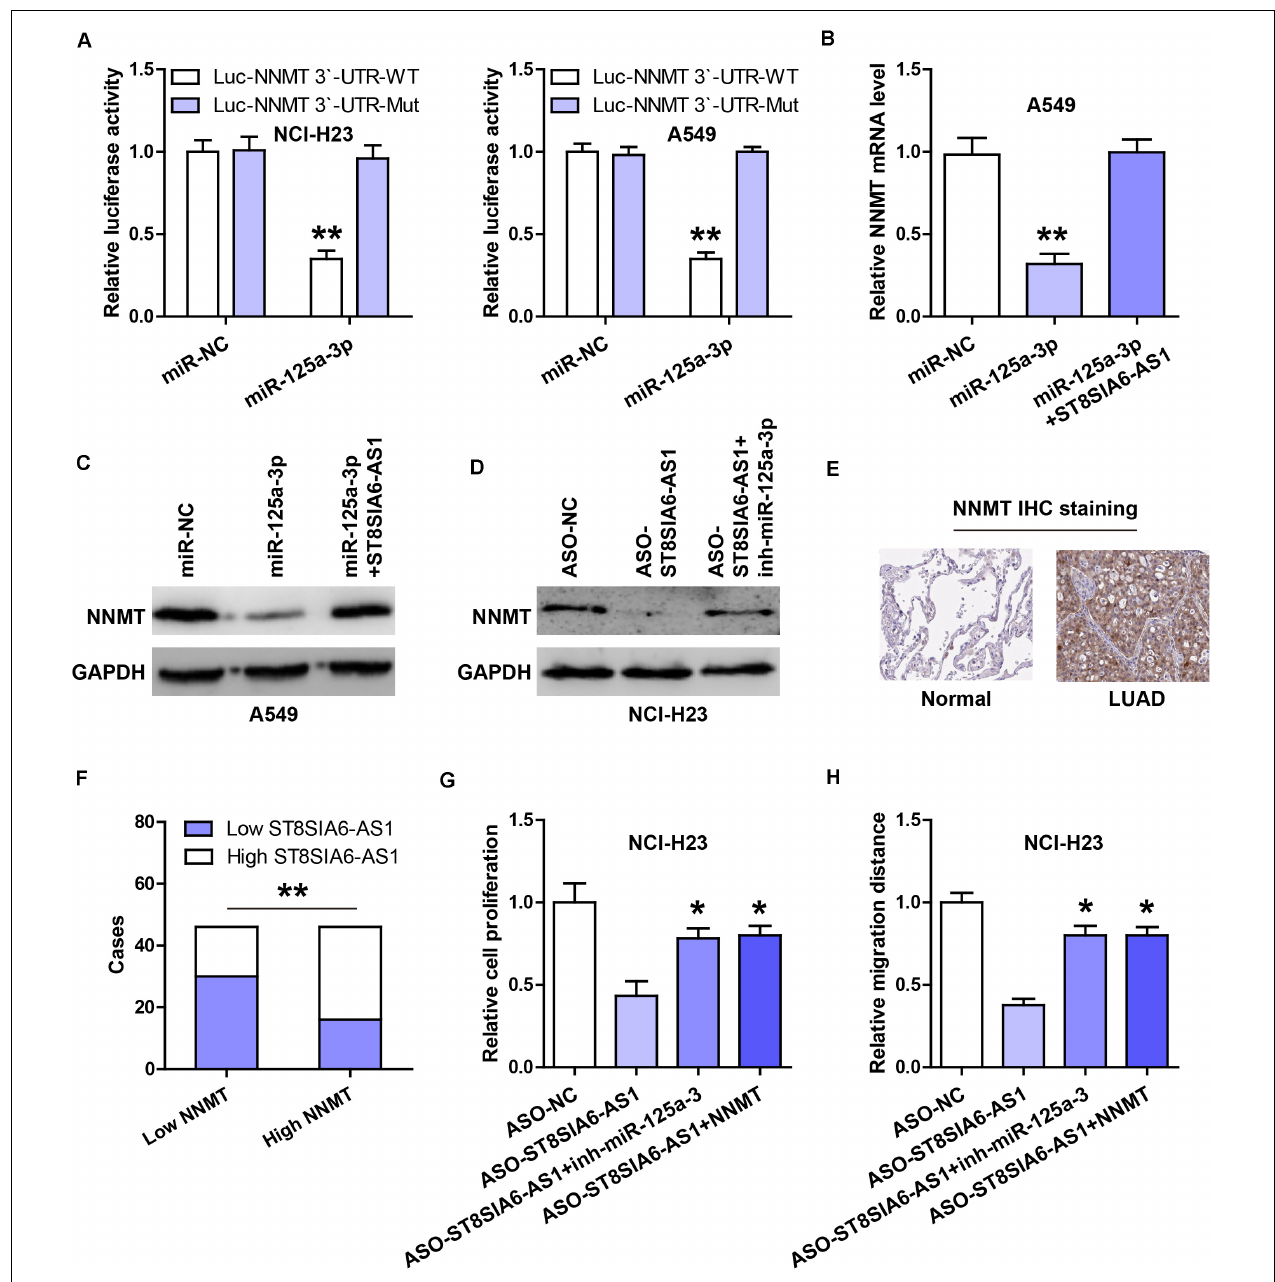
FIGURE 5 | ST8SIA6-AS1 regulates the miR-125a-3p/NNMT axis. (A) Luciferase reporter assay testing the inhibitory effect of miR-125a-3p on NNMT 3’-UTR. (B,C) qRT-PCR and western blot analysis of NNMT mRNA and protein levels in miR-125a-3p-silenced A549 cells transfected with ST8SIA6-AS1 expression vector, respectively. (D) Western blot analysis of NNMT protein level in ST8SIA6-AS1-depleted NCI-H23 cells transfected with miR-125a-3p inhibitors. (E) IHC staining of NNMT in LUAD and normal tissues. (F) The correlation between ST8SIA6-AS1 and NNMT protein in LUAD tissues. (G,H) CCK-8 and transwell assays respectively testing cell viability and migration in ST8SIA6-AS1-depleted NCI-H23 cells transfected with miR-125a-3p inhibitors or NNMT expression vector. * P < 0.05, ** P < 0.01.